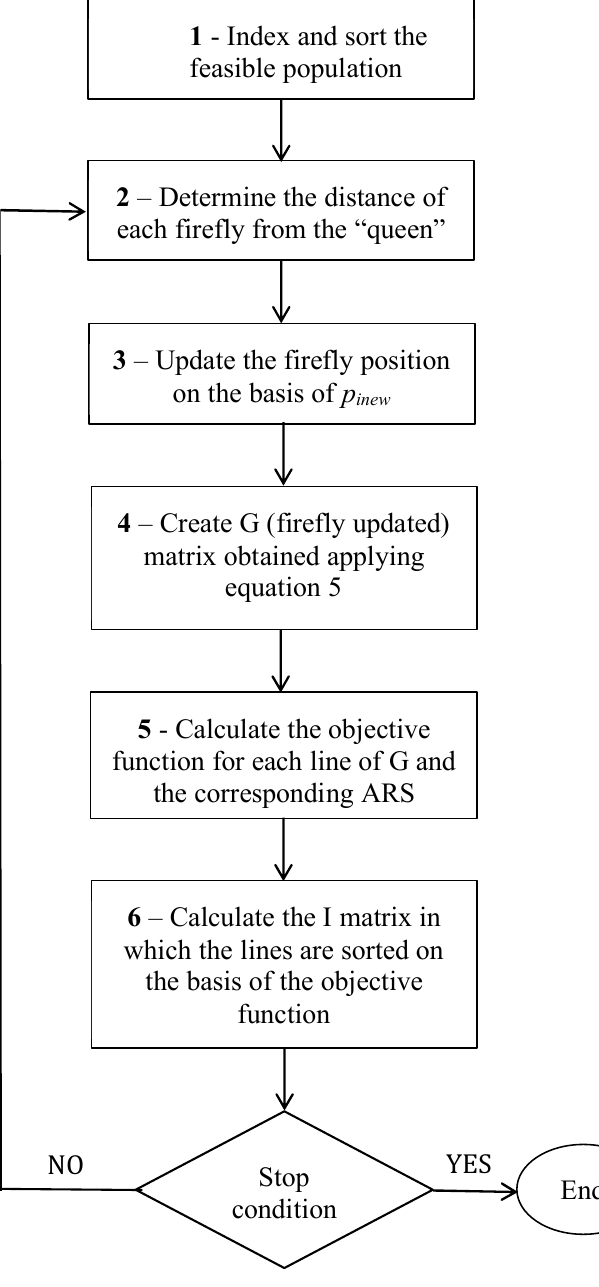
Fig. 2. Flow chart of FA optimization